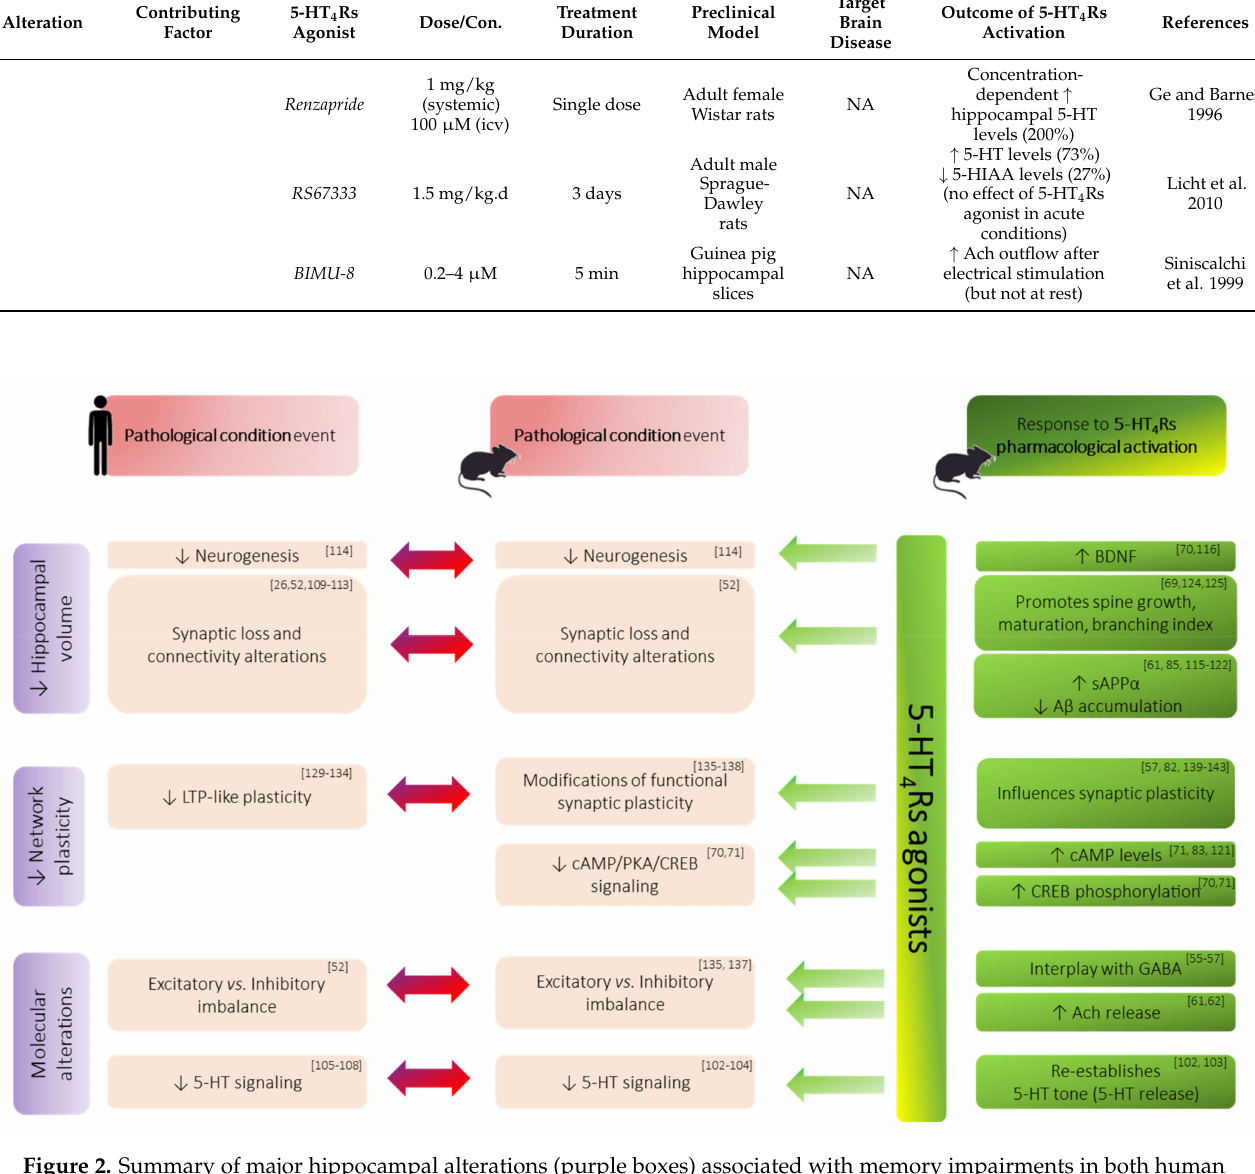
Figure 2. Summary of major hippocampal alterations (purple boxes) associated with memory impairments in both human and animal models of amnesic condition (red boxes). The beneficial effects of 5-HT 4 Rs pharmacological activation are represented at each level of alteration (green boxes). ↑ denotes an increase; ↓ denotes a decrease. Abbreviations: A β : beta- amyloid peptide; Ach: acetylcholine; BDNF: brain derived neurotrophic factor; cAMP: cyclic adenosine monophosphate; CREB: cAMP response element-binding protein; GABA: gamma-aminobutyric acid; LTP: long-term potentiation; PKA: protein kinase A; sAPP α : soluble alpha-amyloid precursor protein; 5-HT: serotonin; 5-HTR: serotonin